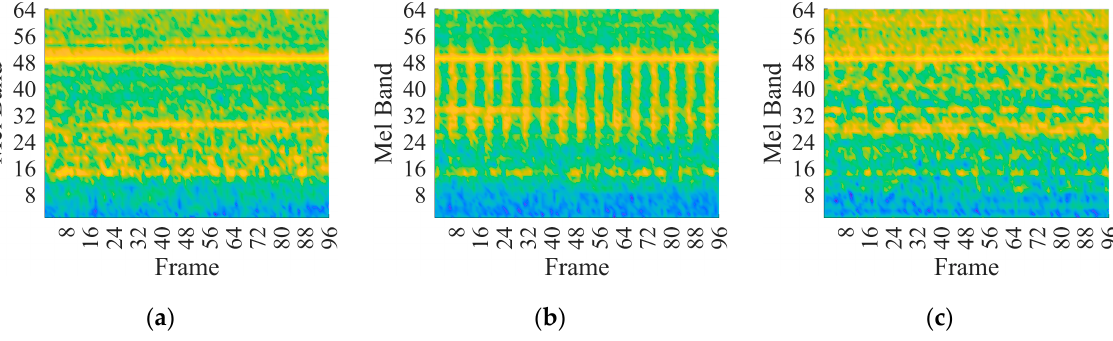
Figure 8. Mel spectrogram at 997 rpm and 124.8 kN radial load: ( a ) normal health state; ( b ) IR damage; ( c ) OR damage.